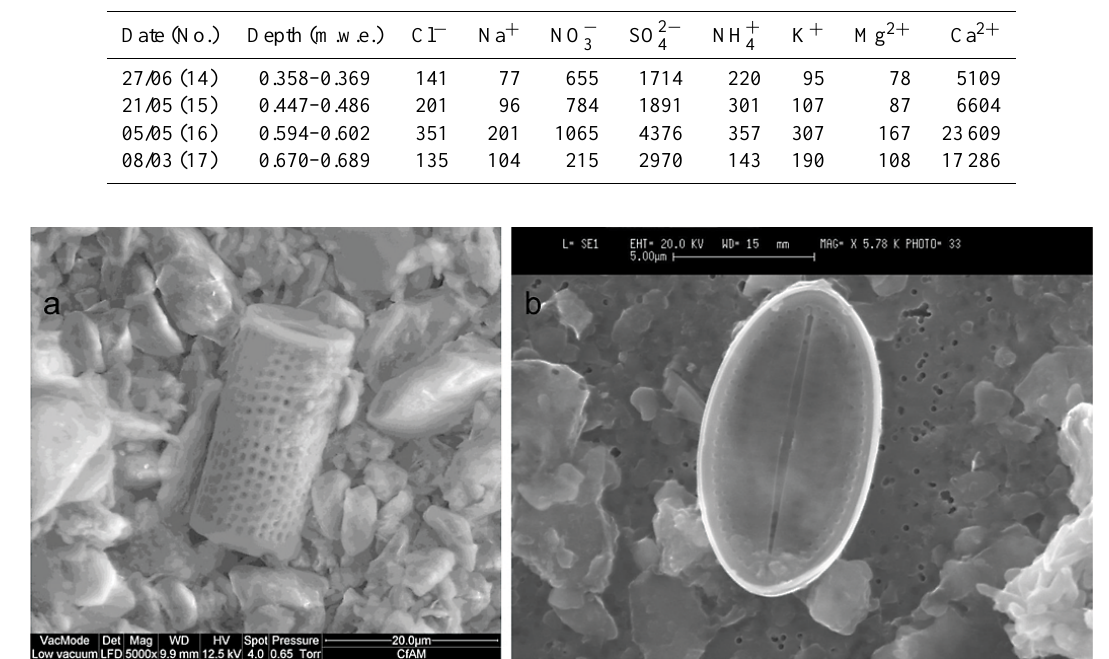
Table 2. Concentrations of major ions in the 2009 snow pit samples containing dust layers (ppb).